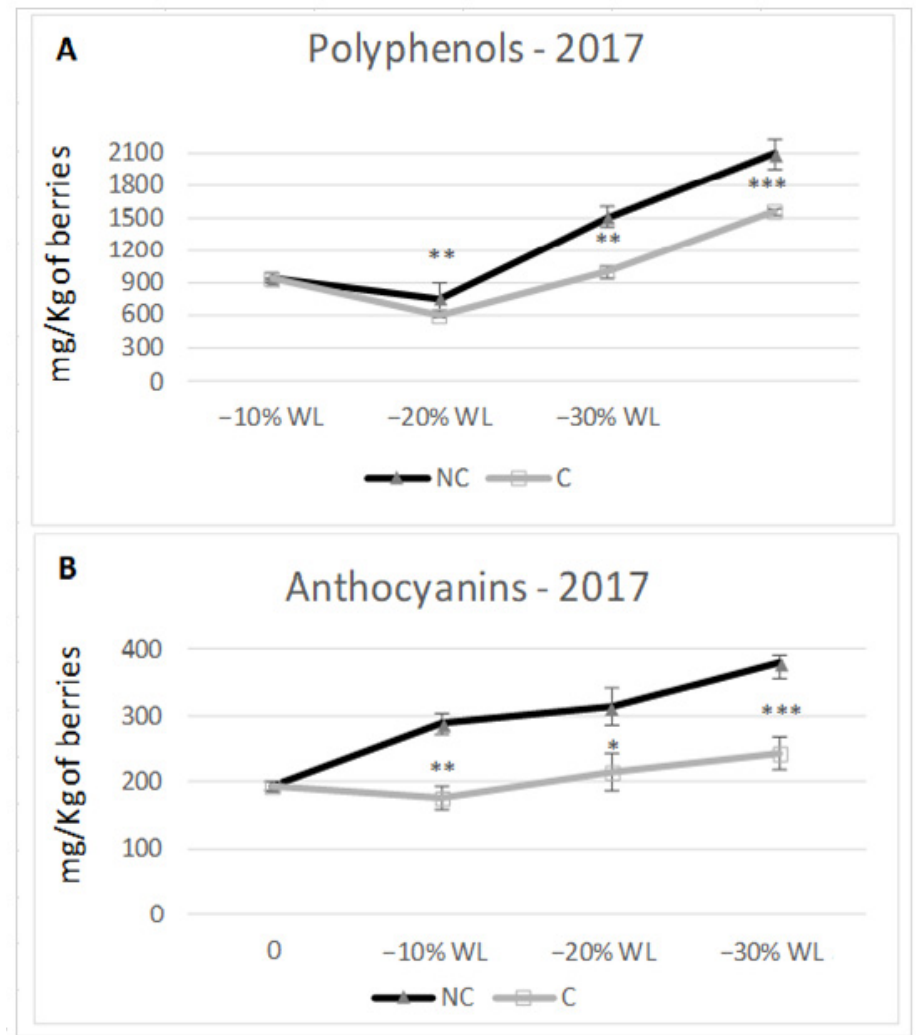
Figure 8. Content in polyphenols ( A ) and anthocyanins ( B ) in 2017. *; **; *** indicate a significant difference ( p ≤ 0.05, 0.01, 0.001) between C and NC treatment. Vertical bars indicate standard deviation of 3 analytical replicates .